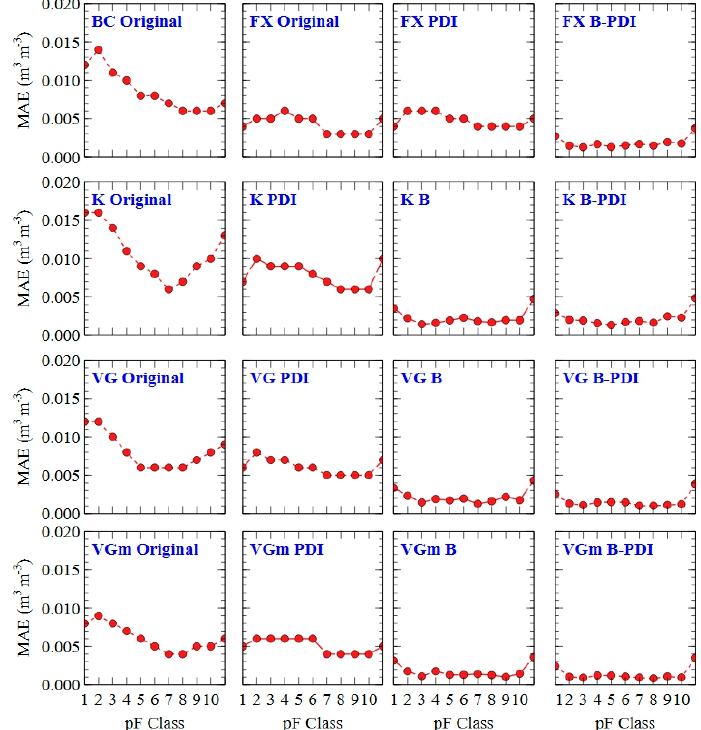
Figure 5. Performance of the 16 models at different suctions. BC: Brooks and Corey [7], FX: Fredlund and Xing [9], K: Kosugi [12], VG and VG m : van Genuchten [15] constrained and unconstrained